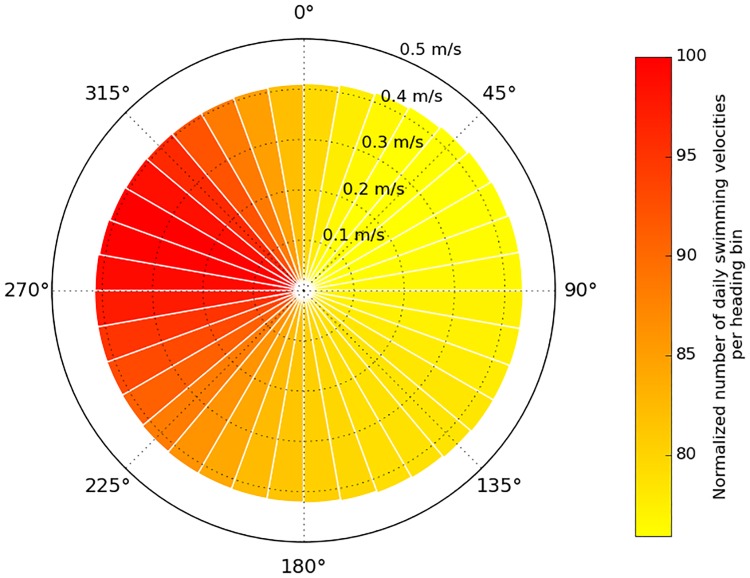
Circular histogram of the daily swimming velocities.This histogram includes the daily swimming velocities of all active turtles found between 120°E and 140°W and north of 25°N. The color in each 10°-wide heading bin reflects the number of daily swimming velocities found in this bin. This number is normalized so that the most populated bin has an index of 100.